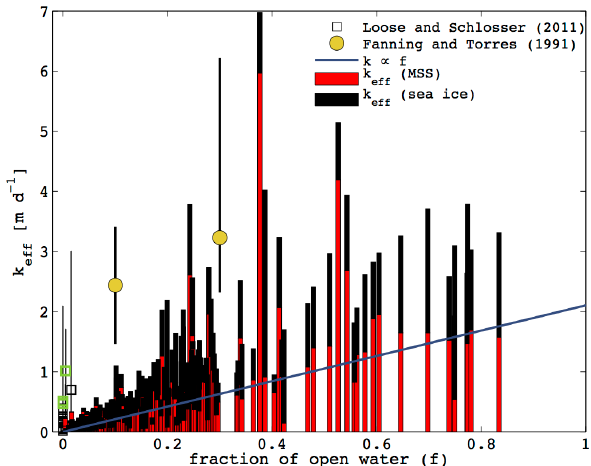
2 Figure 10. The effective gas-transfer velocity ( k eff ) plotted versus the open water fraction; 3 Fig. 10. The effective gas-transfer velocity ( k eff ) plotted versus the adapted from Loose and Schlosser (2011), including estimates of the gas transfer velocity from 4 open water fraction; adapted from Loose and Schlosser (2011), in- the radon deficit method from Fanning and Torres (1991). The stacked bars indicate estimates of 5 cluding estimates of the gas transfer velocity from the radon deficit k eff from sea ice zone effects (sea ice) and from surface wind waves (MSS), during the drift 6 method from Fanning and Torres (1991). The stacked bars indicate tracks of ITP 3, 6, 7, and 8 computed using equation (2) of this study. 7 estimates of k eff from sea ice zone effects (sea ice) and from sur- face wind waves (MSS), during the drift tracks of ITP 3, 6, 7, and 8 computed using Eq. (2) of this